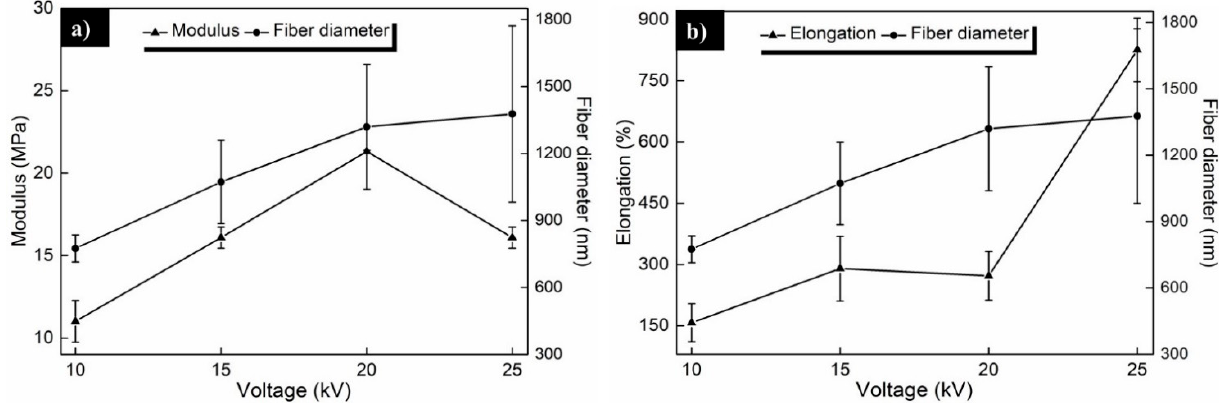
Figure 8 . ( a ) Modulus and fiber diameter, and ( b ) elongation and fiber diameter vs. applied voltage of the obtained electrospun PCL fibers.